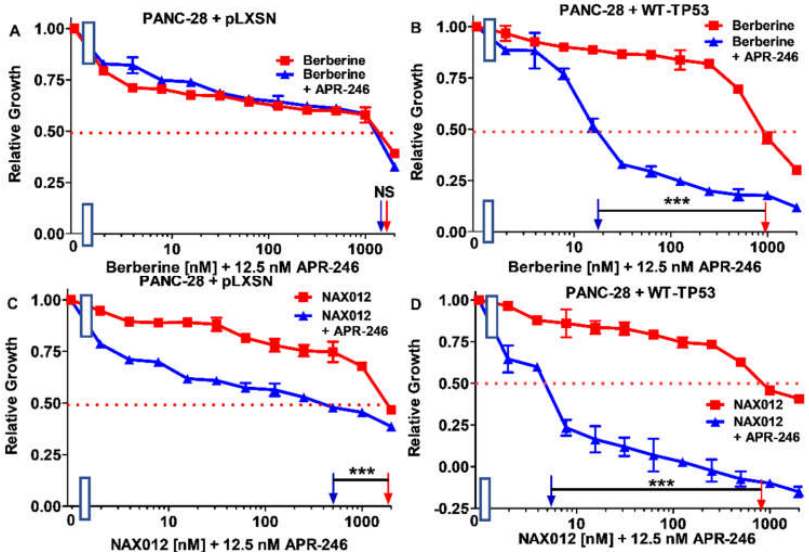
Figure 11. APR-246 enhances the effects of berberine when WT-TP53 is present in PANC-28 cells, while APR-246 enhances the effects of NAX012 in PANC-28 cells in the presence of WT-TP53 greater than in the absence of WT-TP53. Panel ( A ) PANC-28 + pLXSN cells treated with different concentrations of BBR (red squares) or PANC-28 + pLXSN cells treated with different concentrations of BBR and a low dose of APR-246 (blue triangles). Panel ( B ) PANC-28 + WT-TP53 cells treated with different concentration of BBR (red squares) or with different concentrations of BBR and a low dose of APR-246 (blue triangles). Panel ( C ) PANC-28 + pLXSN cells treated with different concentrations of NAX012 (red squares) or with different concentrations of NAX012 and a low dose of APR-246 (blue triangles). Panel ( D ) PANC-28 + WT-TP53 cells treated with different concentration of NAX012 (red squares) or with different concentrations of NAX012 and a low dose of APR-246 (blue triangles). Table 2. Effects of WT-TP53 on the sensitivity of PANC-28 PDAC cells to APR-246 1 . These experiments were repeated 3 times and similar results were observed. *** = p < 0.0001, and NS, not statistically significant.